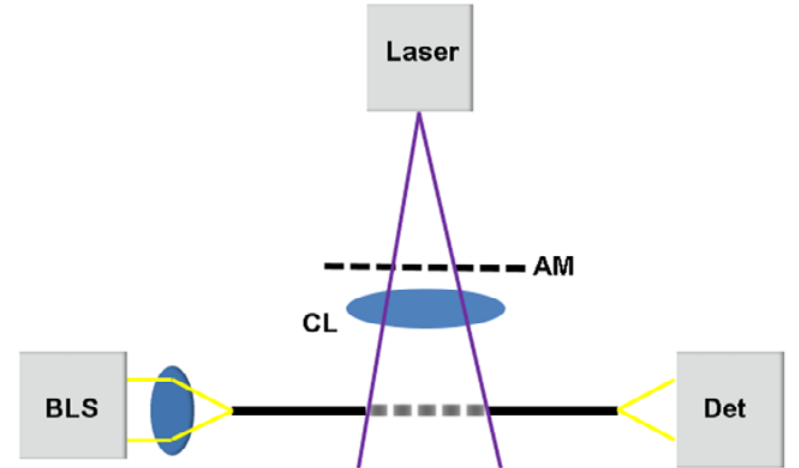
Figure 9. The setup for UV-induced LPG inscription and detection. The UV laser illuminates the amplitude mask (AM), and the generated LPG pattern is focused by a cylindrical lens (CL) in one transversal dimension onto the fiber. During the UV exposure, light is coupled into the fiber using a broadband light source (BLS), and the resulting LPG spectrum is detected at the end of the fiber using an optical spectrum analyzer (OSA) as a detector (Det).